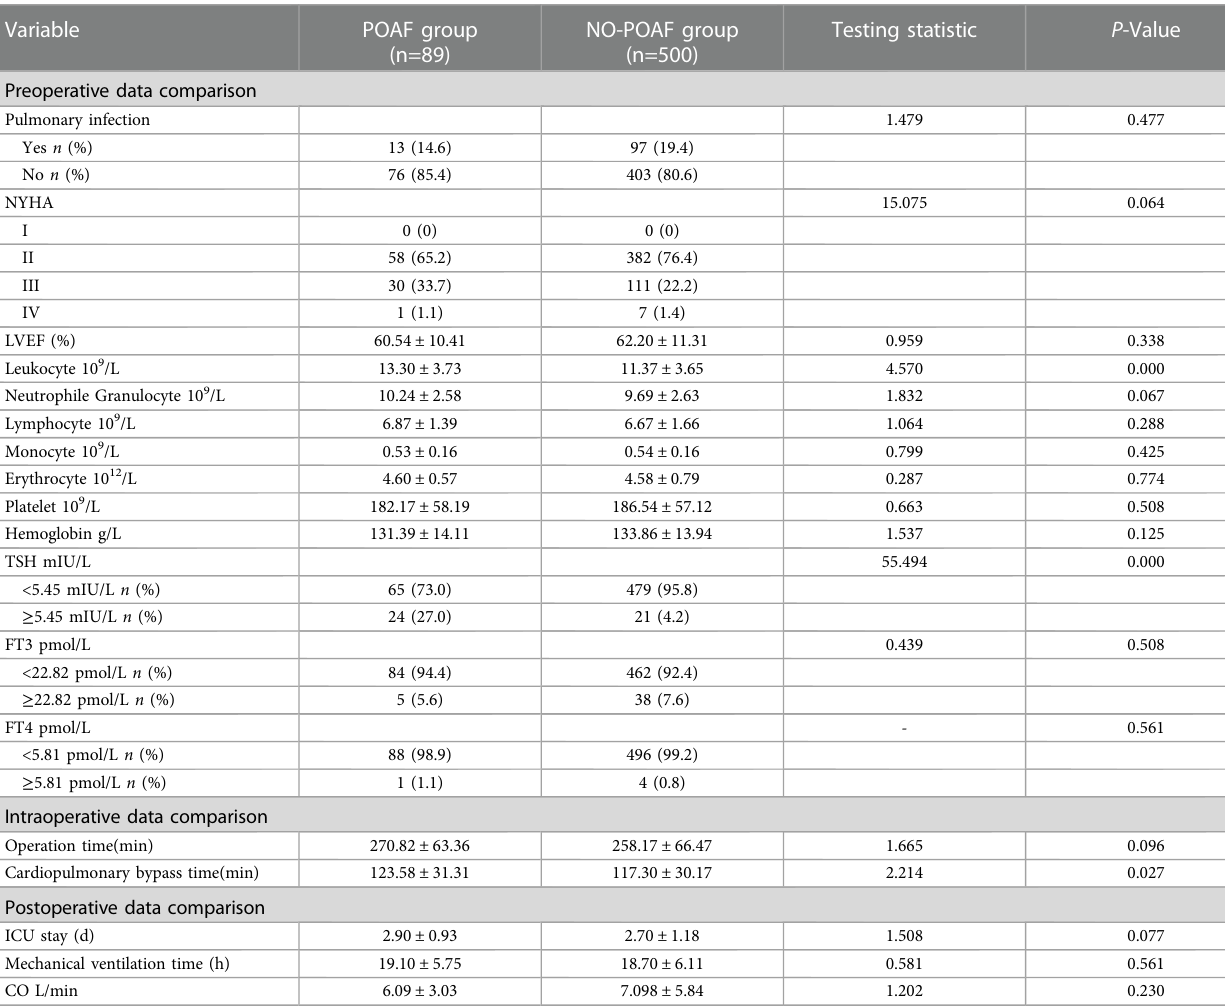
TABLE 2 Preoperative data of two groups of